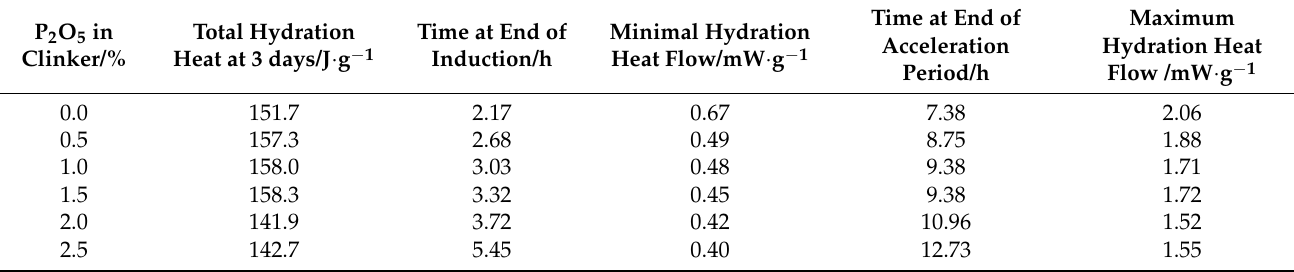
Table 3. Eigenvalues of hydration heat flow released by phosphorus-bearing cements.